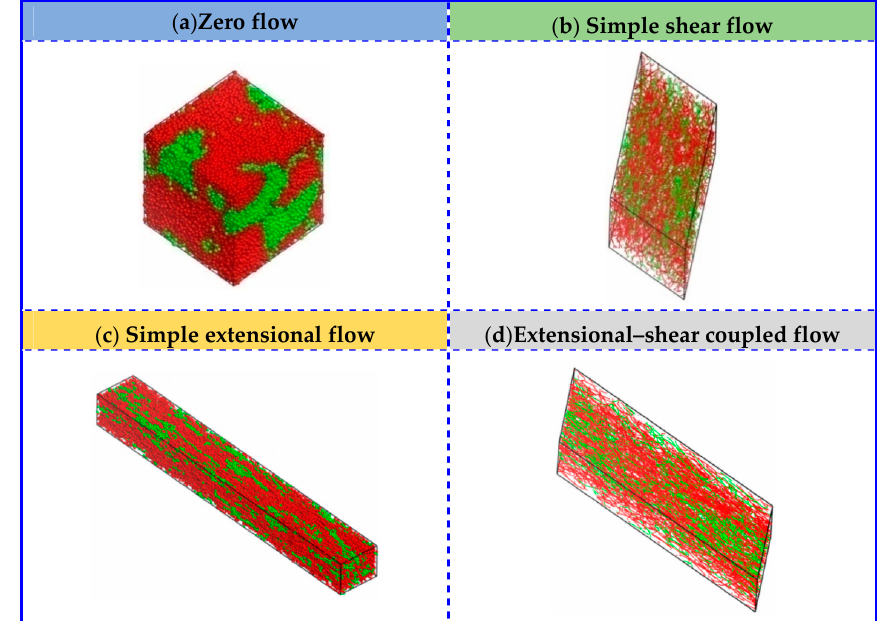
Figure 6. Comparison of UHMWPE/PA6 blends of 30/70 mass fractions under zero flow, simple shear flow, simple extensional flow and extensional–shear coupled flow.( b , d ) are displayed in line style and the others are presented in dot-line style.